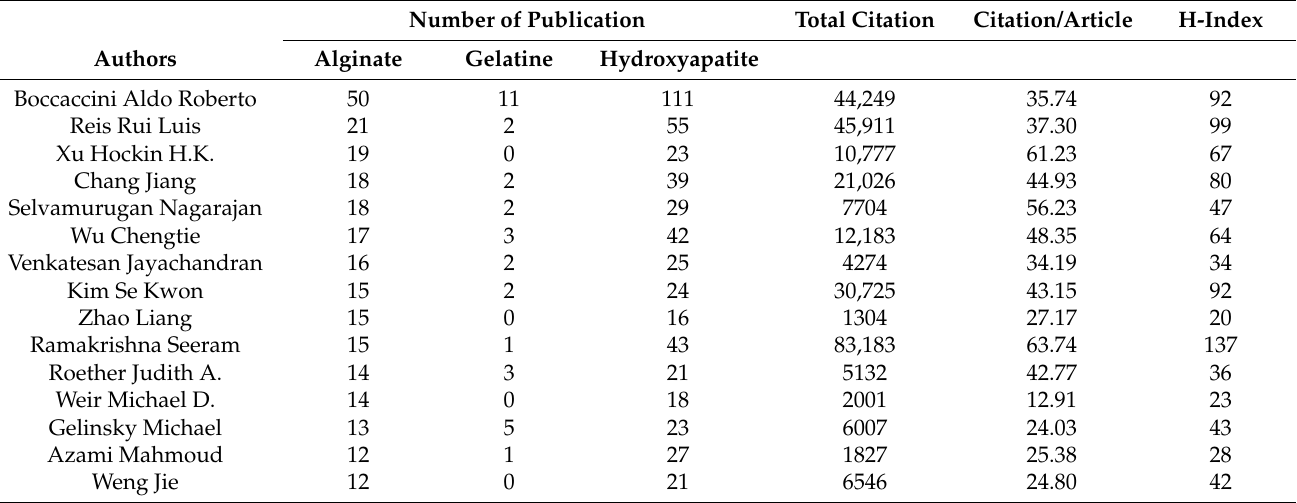
Table 4. Authors with the highest number of publications